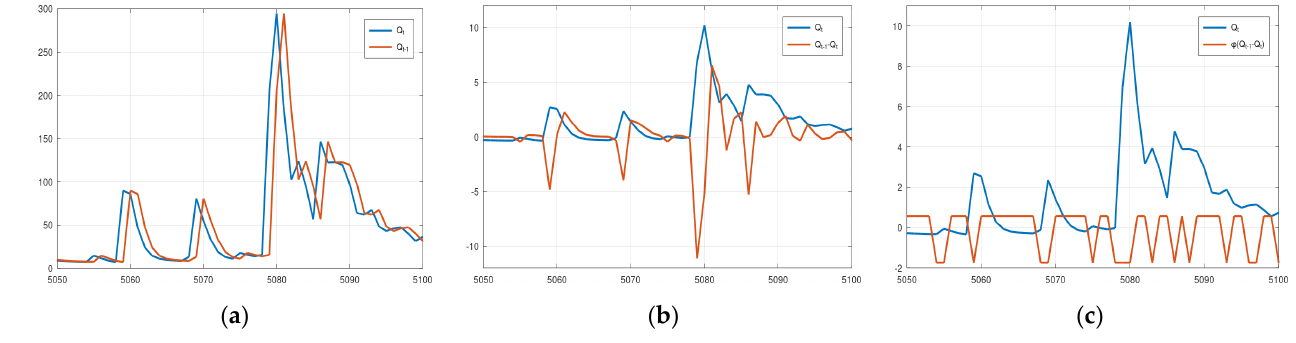
Figure 8. The elements of status vector x : ( a ) 2D Option 1; ( b ) 2D Option 2; ( c ) 2D Option 3. The results of KNN and Blueacat displayed in Figures 2–7 indicate only insignificant differences between the two methods. Figures 3 and 6 indicate that the “Median” line is closer to the “True” line than the Equality line, which means that the former is less biassed compared to the simulation values (Table 1). Furthermore, the upper bound of the